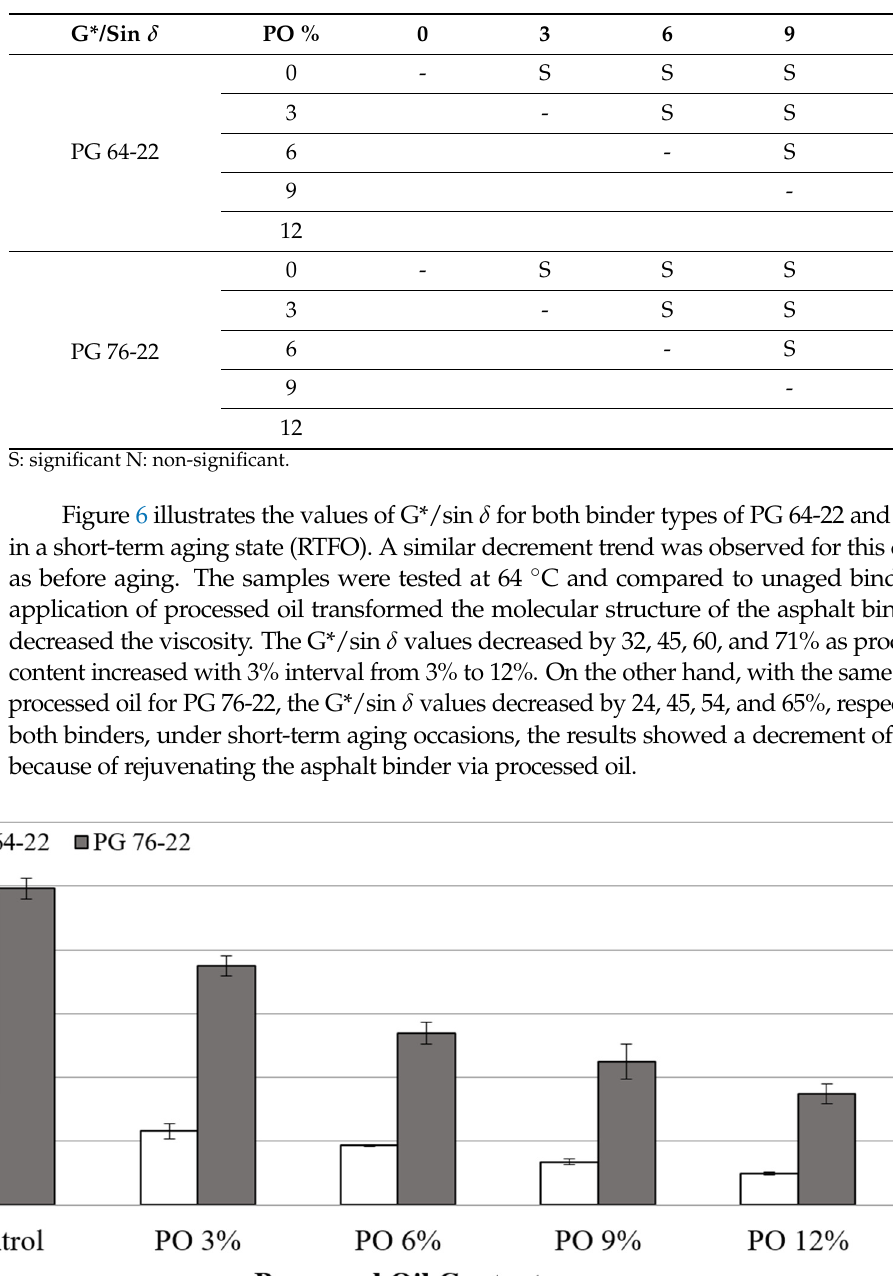
Table 5. Statistical analysis results of the G*/sin δ as a function of processed oil content ( α = 0.05).